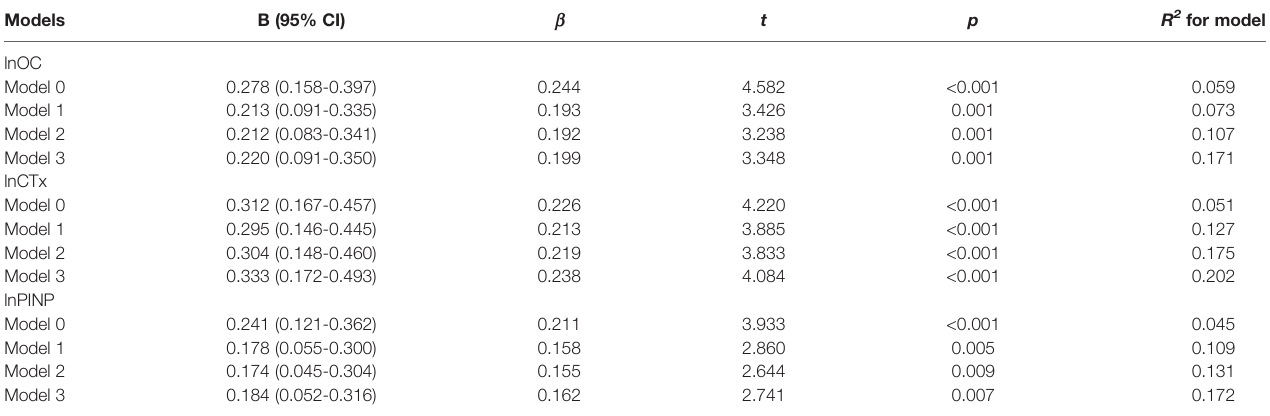
TABLE 3 | Multiple linear regression models displayed independent associations of the LDL-C/Apo B ratio with BTMs levels. Models